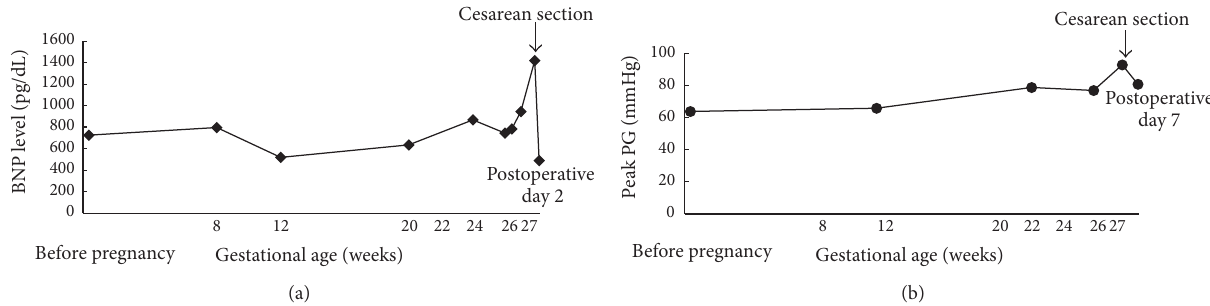
Figure 1: Ontogeny of brain natriuretic peptide levels (a) and the peak pressure gradient of the left ventricular outflow tract (b) during the perinatal